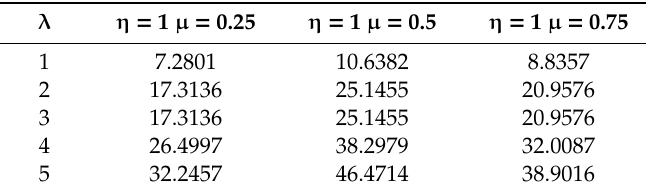
Figure 12. Vibrational modes for the SFG distribution with η = 1 and µ = 0.75: ( a ) 1st mode, ( b ) 2nd mode, ( c ) 4th mode, ( d ) 5th mode. 3.2.3. Free Vibration Analysis for Partially Agglomerated States In a more general situation, one has situations that are distinct from the completely non- agglomerated state or from the completely agglomerated state, hence being very important to achieve a plausible description of the degree of agglomeration through the parameters µ and η [8]. To investigate the free vibrations’ behaviour of simply supported FG-CNTRC square plates, two different partially agglomerated situations were evaluated, one with η <µ and the other with η > µ, when µ = 0.5 for both situations. Table 11 presents the first five natural frequencies for the UD distribution.